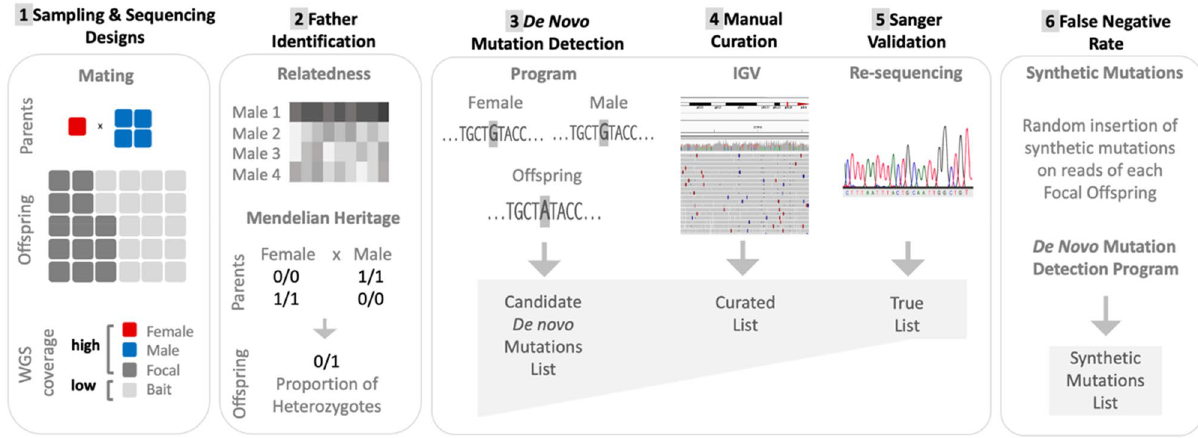
Figure 3. Experimental and analytical designs. Schematics of experimental and analytical procedures for direct mutation rate estimation which includes a series of parameters to exclude false positive mutations and account for false negatives. (1) Sampling & sequencing designs: experimental female and male mating, and whole genome sequencing of parents and offspring at high and low coverage levels. (2) Father identification: two methods are represented (relatedness and Mendelian heritage). (3) De novo mutation detection: candidate de novo mutation is absent from both parents. (4) Manual curation: Integrated Genome Viewer (IGV) for mapping visualization of reads of candidate mutation list. (5) Sanger validation: PCR amplification and re-sequencing of candidate mutation. (6) False Negative Rate (FNR): 1000 synthetic mutations were inserted in each focal offspring; reads are processed and the de novo mutation detection program performed as in